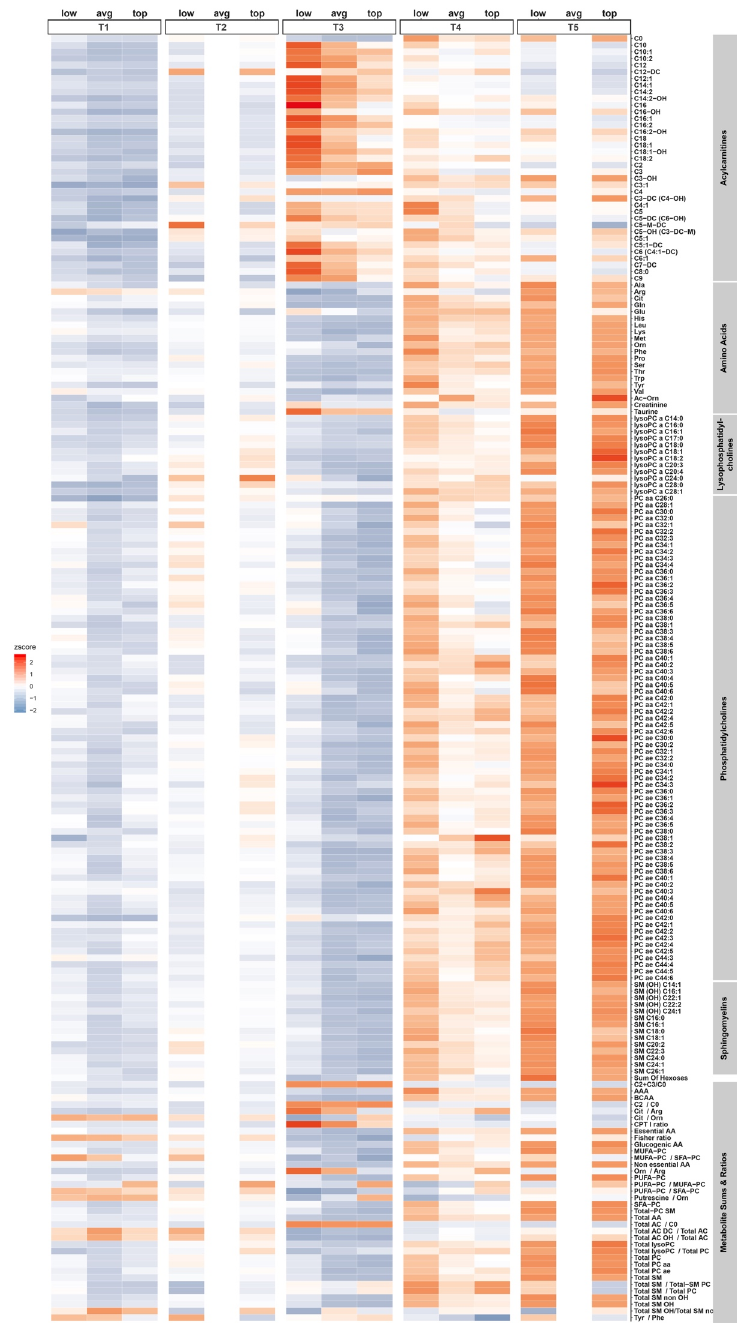
Figure 2. Heatmap of metabolite-wise auto-scaled (z-transformed) metabolite concentrations. Quantification of 188 metabolites including acylcarnitines, amino acids, biogenic amines, hexoses, phospholipids (lysophosphatidylcholines, phosphatidylcholines), sphingolipids (sphingomyelins), and metabolite sums and ratios. Groups included top ( n = 20, top performers, TP), average ( n = 40, average performers, AP), and low ( n = 20, low performers, LP) performers based on endurance capacity (relative VO 2 max) and net marathon finishing time. Blood samples were collected at time points T1 (training phase), T2 (tapering phase), T3 (immediately after the race), T4 (24 h post-race), and T5 (72 h post-race). All blood samples were measured for the TP and LP groups, with T1, T3, and T4 measured for the AP group.